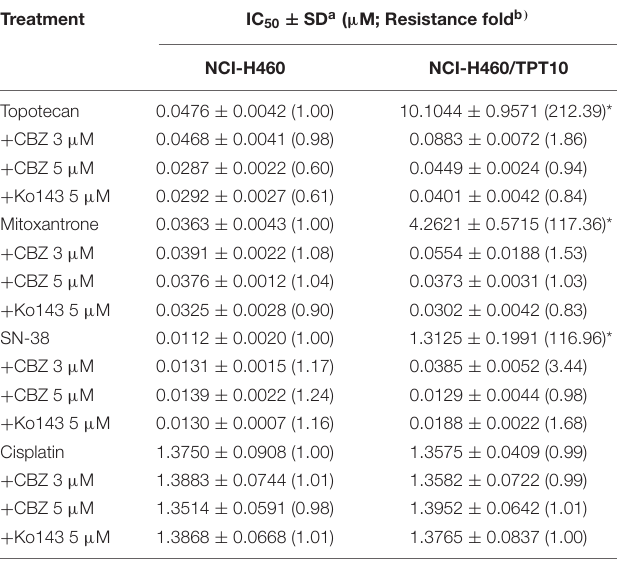
TABLE 1 | The drug-resistance of NCI-H460/TPT10 and the reversal effect with cabozantinib.